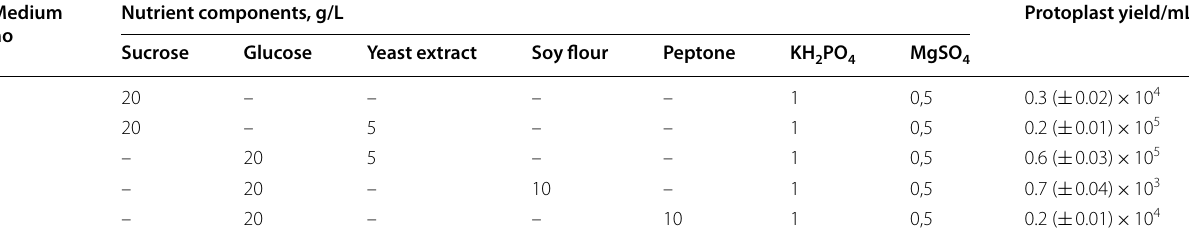
Table 1 Influence of medium composition on G. zeae protoplast formation Medium Nutrient components, g/L Protoplast no